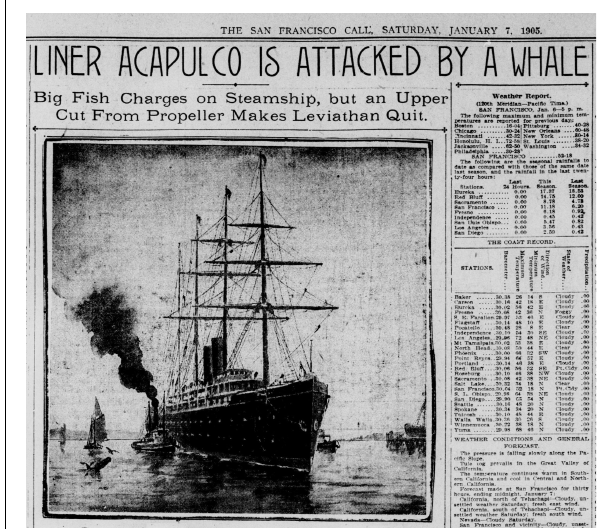
FIGURE 1 | An article published in the “San Francisco Call” (United States) (January 7, 1905), describing a live whale being struck by an 85 m steam ship of the Pacific Mail Steamship Company, near to San Blas, Nayarit, Mexico, whilst the vessel traveled between Panama and California (Unites States). Sensationalized headlines such as this were typical of the period (Image: San Francisco